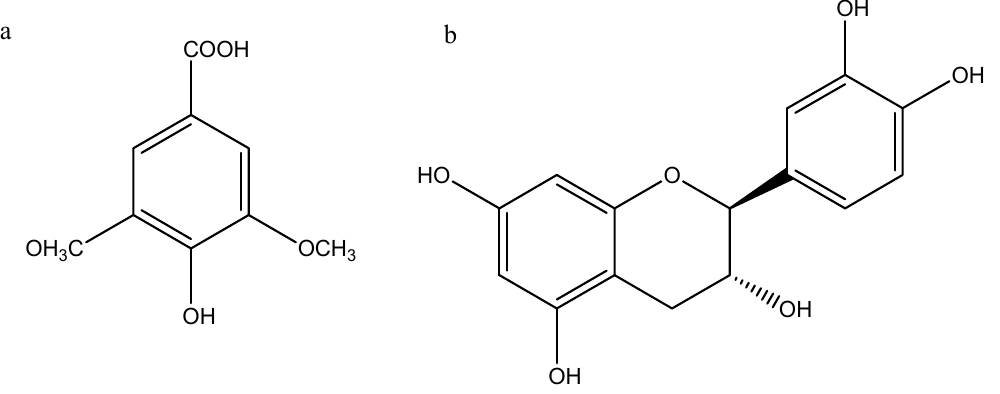
Figure 3. Structures of ( a ) syringic acid and ( b )